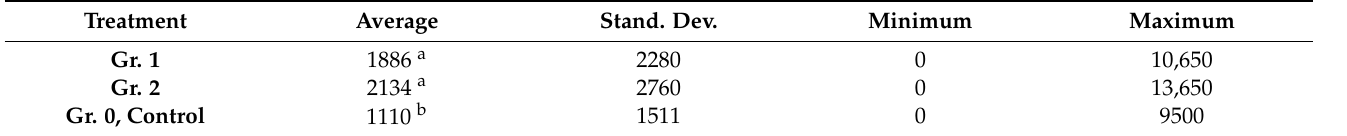
Table 2. Excretion of coccidial oocysts per gram of faeces (opg) in each experimental group. Treatment Average Stand. Dev.